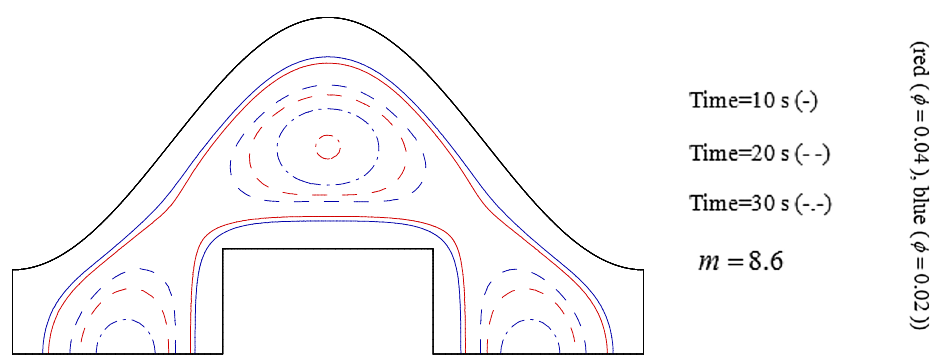
Figure 5. Roles of ϕ on transient phenomena.